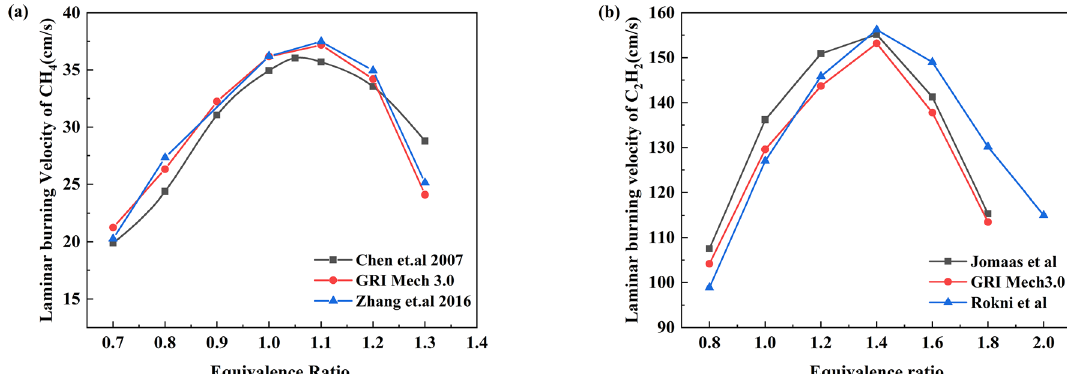
Figure 3. Laminar burning velocity verification [( a ) methane, ( b ) acetylene].